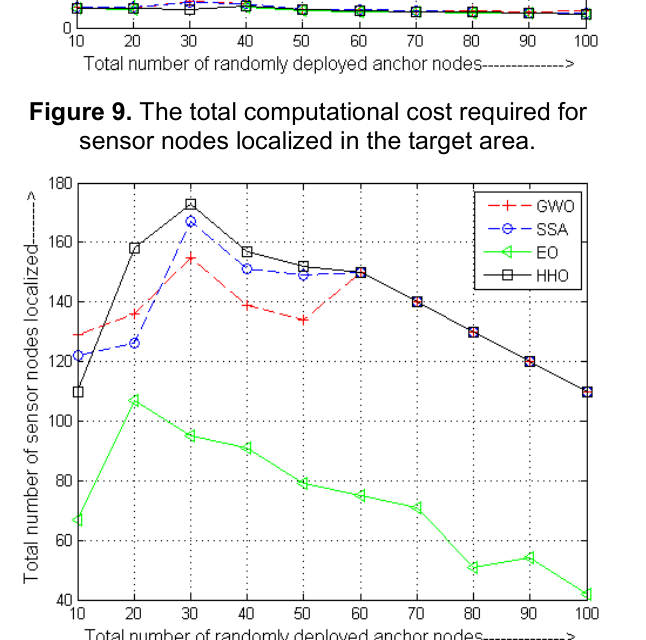
Figure 10. The total number of sensor nodes localized in the target